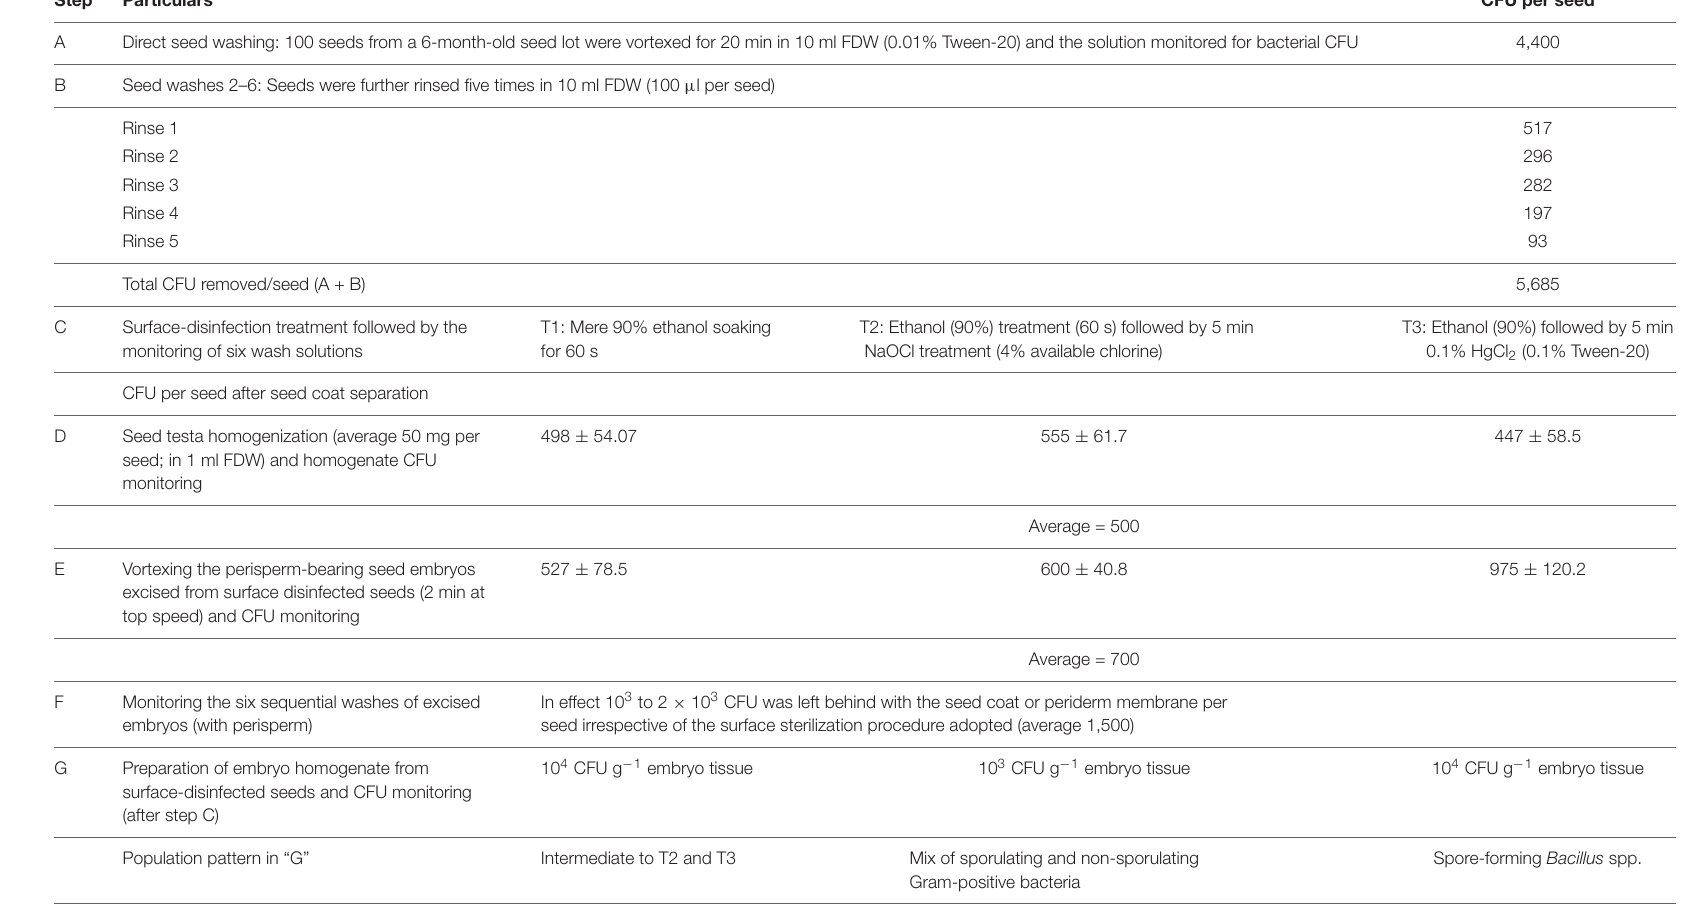
TABLE 1 | Bacterial CFU detected with 6-month refrigeration-stored seeds of watermelon “Arka Manik” adopting different surface disinfection methods. Step Particulars CFU per